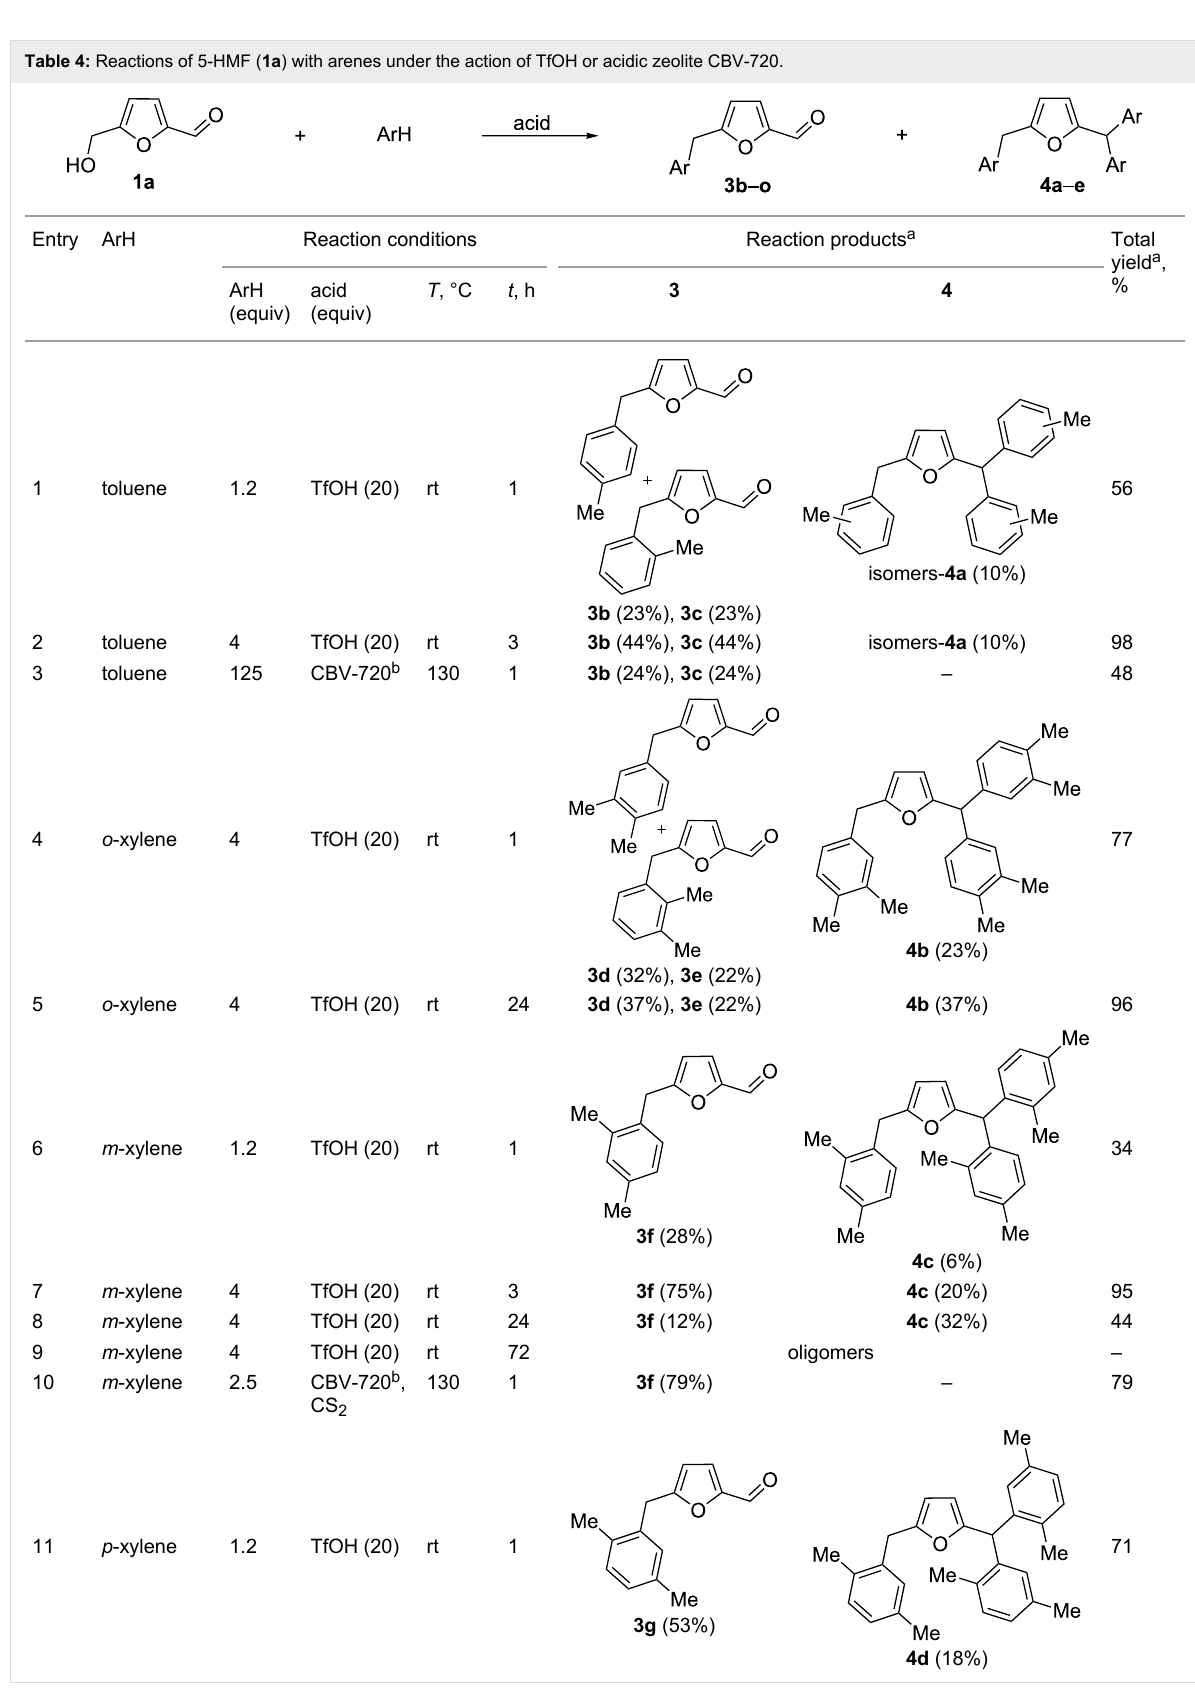
Table 4: Reactions of 5-HMF ( 1a ) with arenes under the action of TfOH or acidic zeolite CBV-720.